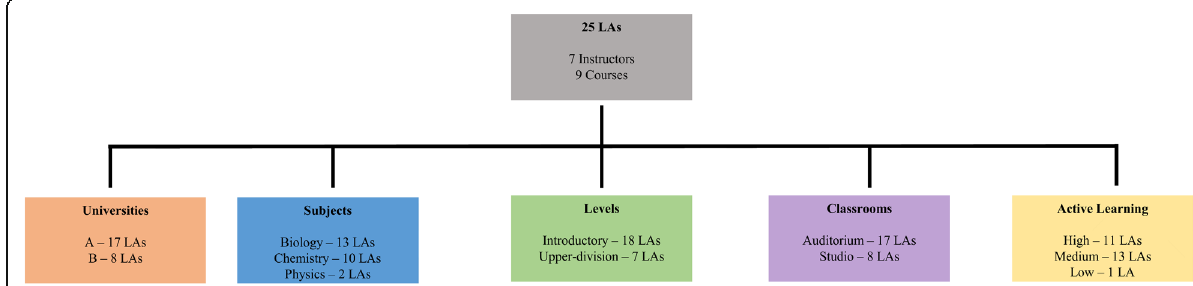
Fig. 2 Types of courses in which LA video data was collected for this study